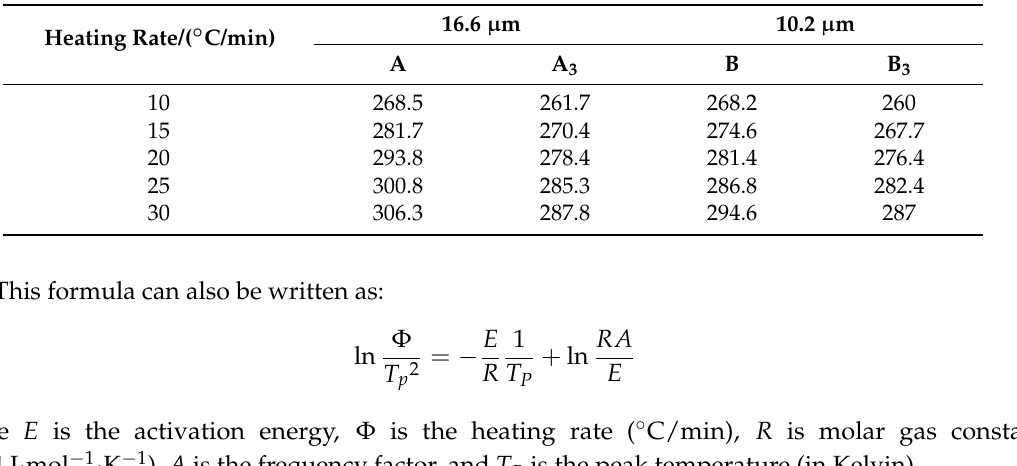
Table 3. DSC data of plasticized spinning PAN fibers.